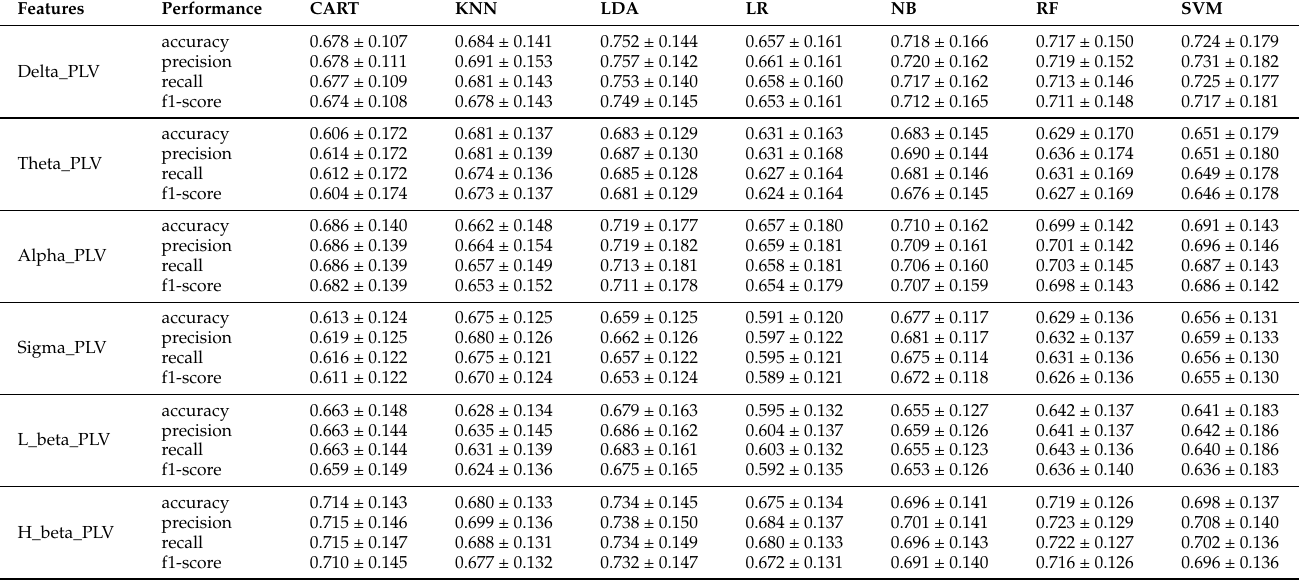
Table 5. The summary of average accuracies and standard deviations of PLV’s significant connectivity network features from each